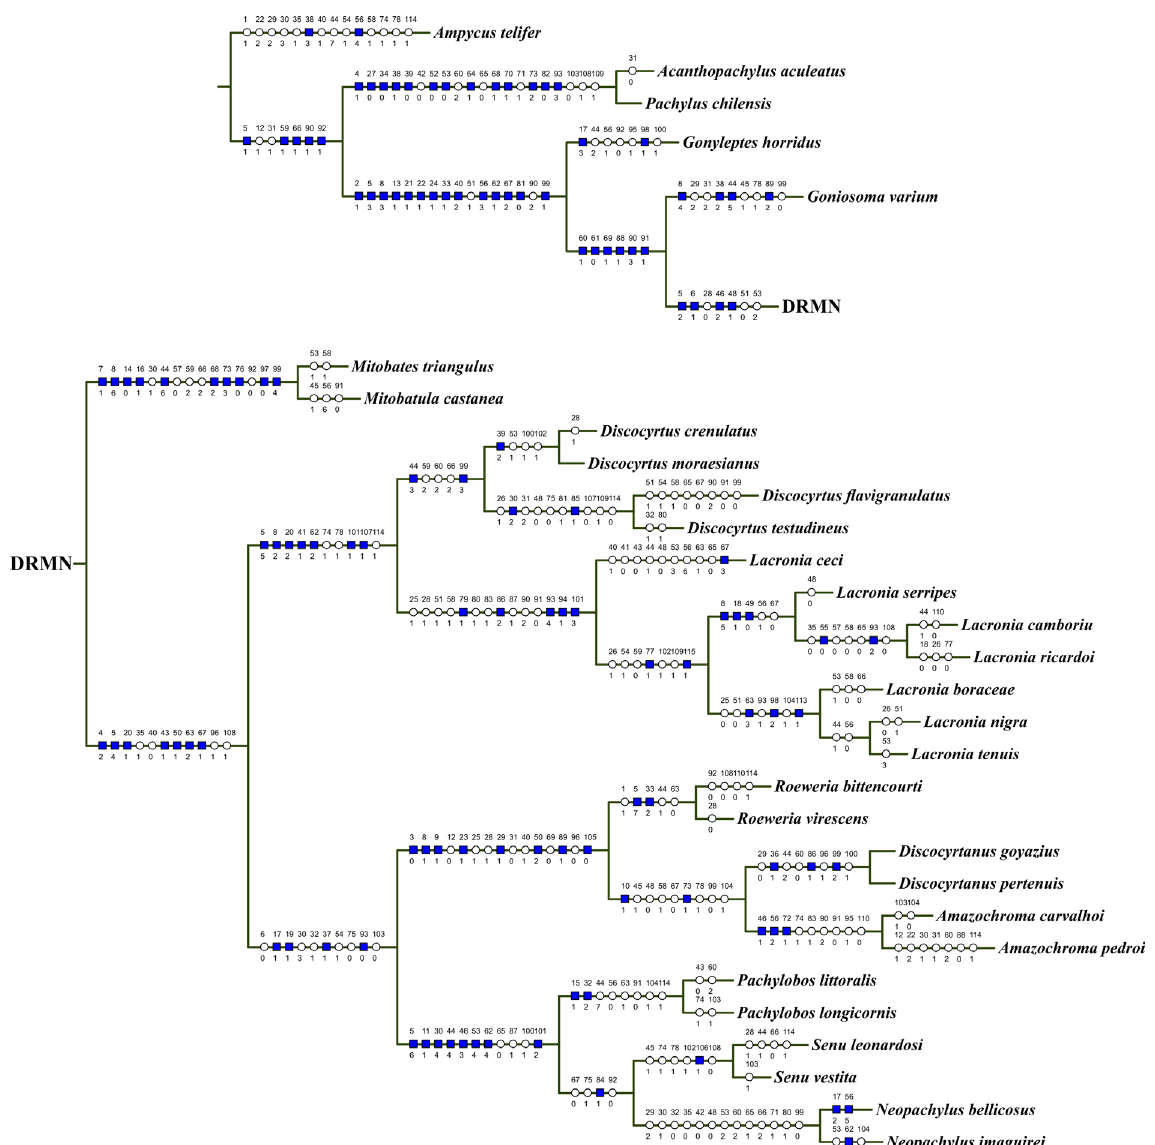
Fig. 2. Cladogram depicting phylogenetic relationships of Lacronia Strand, 1942 and the outgroups, with synapomorphies supporting each clade mapped using ACCTRAN optimization. The tree represents the topology with shortest number of steps (k-values = 3.2, 4, 5, 6, 10, 15 and 20) recovered by TNT. Blue squares = nonhomoplastic synapomorphies; white circles = homoplastic synapomorphies. Numbers above symbols are the characters numbers. Numbers under symbols are the states